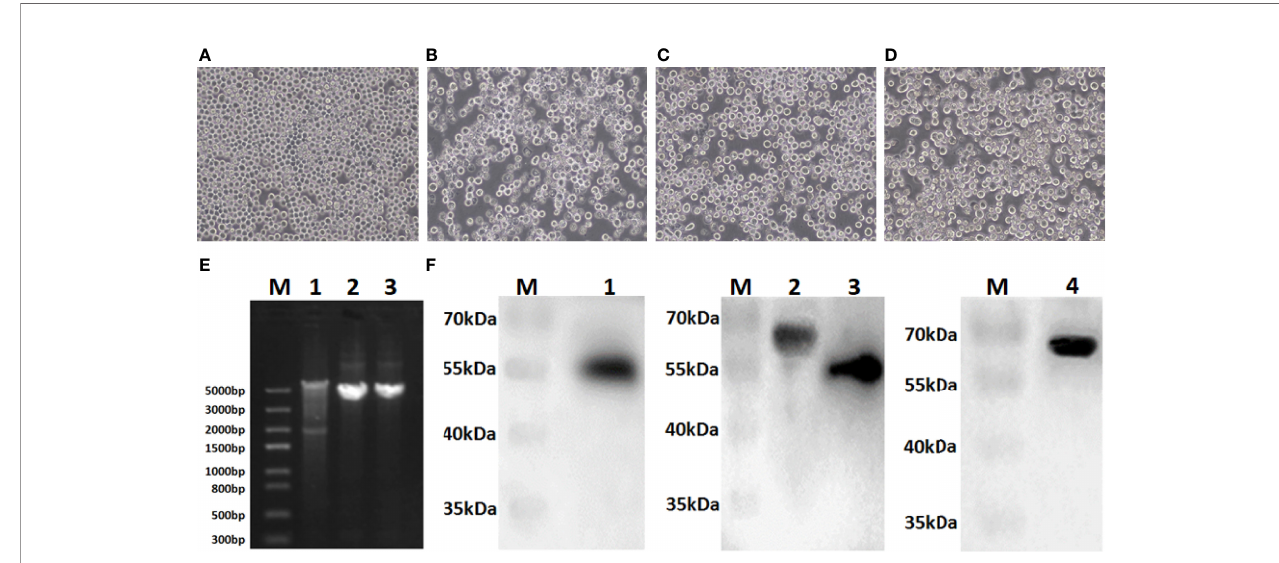
FIGURE 3 | Identi fi cation of recombinant baculoviruses. Panel (A) Normal Sf9 cells; Panels (B – D) indicate the cytopathic effect of Sf9 cells after infection with recombinant baculoviruses rBV-GagN2, rBV-H9 or rBV-H3. Panel (E) indicates the PCR identi fi cation of recombinant baculovirus genomes with M13 primers. Lane M: Trans5K DNA marker; Lane 1: rBV-GagN2; Lane 2: rBV-H9; Lane 3: rBV-H3. The GagN2, H9 and H3 fragments were approximately 5,725bp, 4,001bp and 3,983bp, respectively. Panel (F) indicates the Western blot result of the foreign proteins expressed by recombinant baculoviruses. Lane M: Protein molecular weight standard; Lane 1: Gag; Lane 2: H9 HA; Lane 3: NA; Lane 4: H3 HA. The molecular weights of Gag, H9, N2, and H3 were approximately 54kDa, 63kDa, 52kDa, and 63kDa,